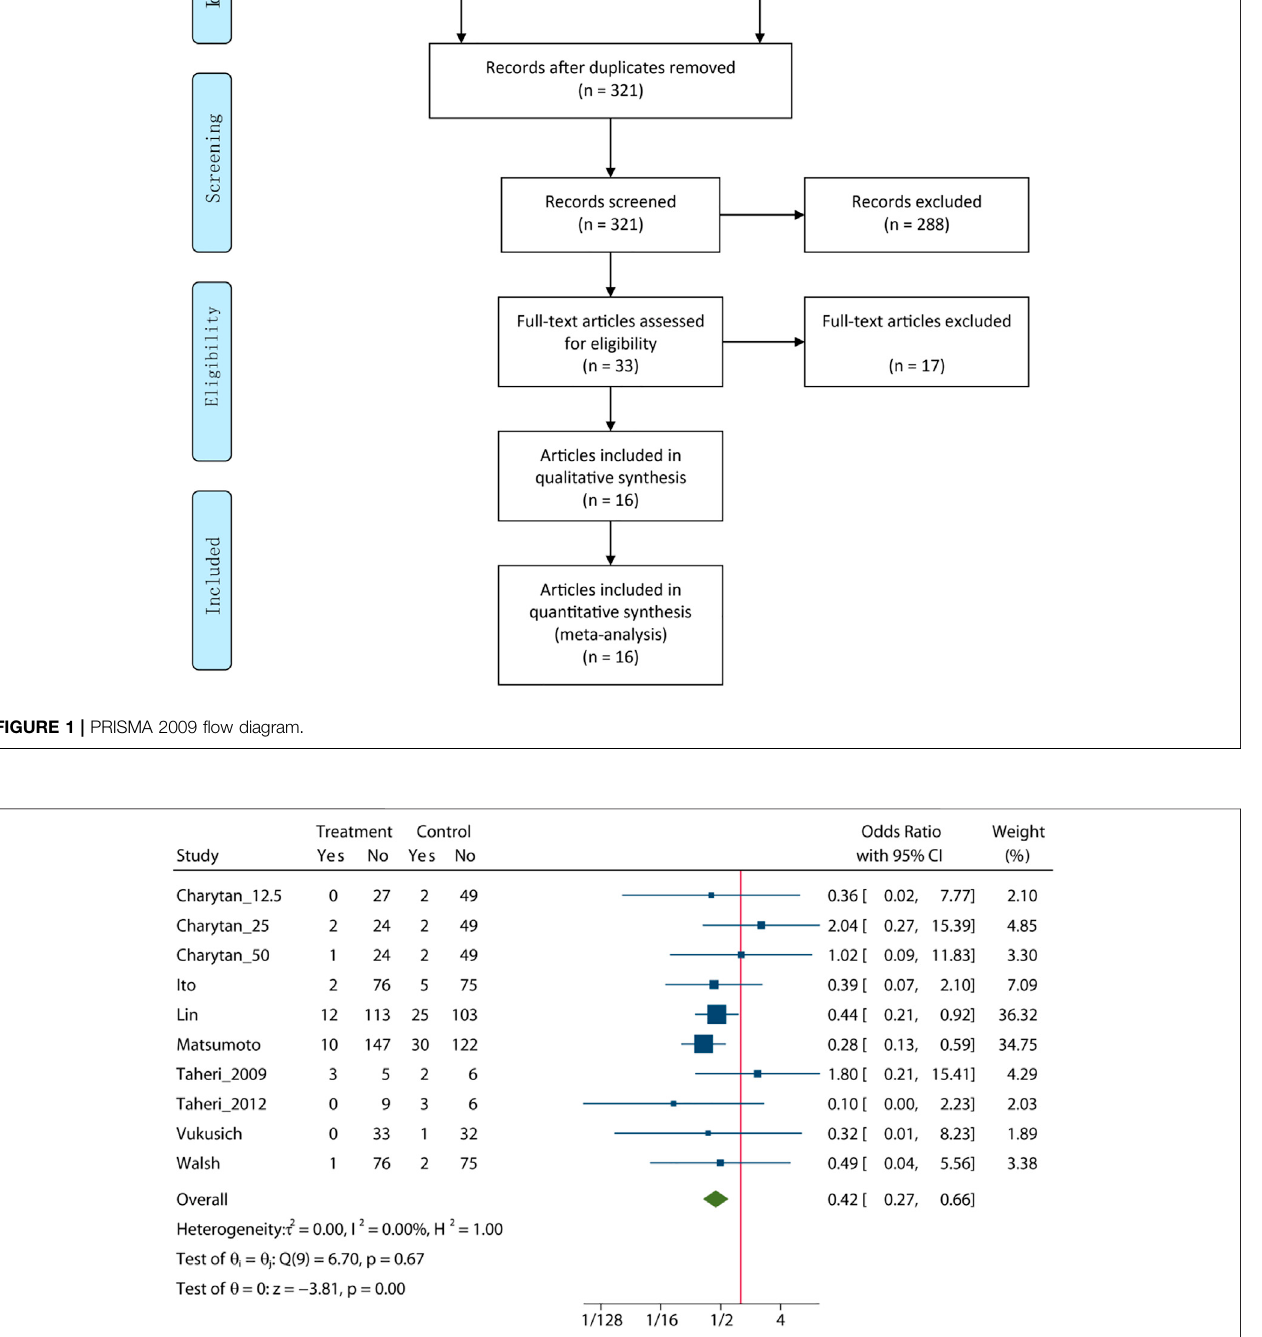
Frontiers in Pharmacology |